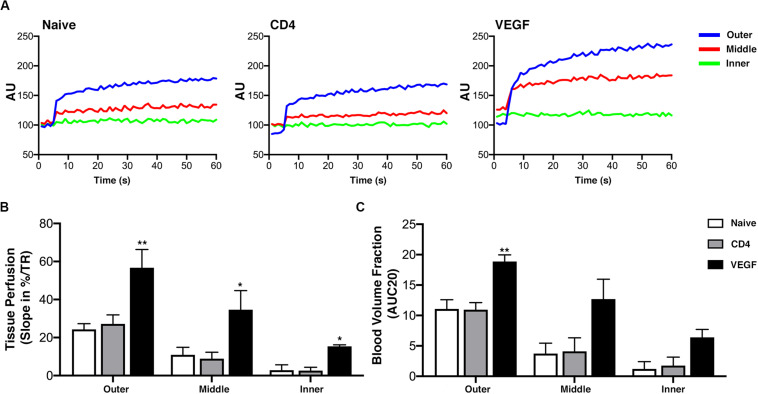
Early blood flow inside the constructs assessed non-invasively by dynamic contrast-enhanced magnetic resonance imaging (DCE MRI) at 1 week after implantation (n = 4). (A) DCE-MRI signal time-course for each layer in naïve, CD4 and VEGF-expressing constructs, expressed in arbitrary units (AU). (B) Tissue perfusion computed from contrast “wash-in,” i.e., the initial uprising slope of the signal-time curve, expressed as the percentage increase over repetition time (%/TR). (C) Blood volume fraction determined from the initial area under the normalized DCE curve at 20 dynamic scans after contrast arrival (AUC20) for each layer and construct (*p < 0.05, **p < 0.01).